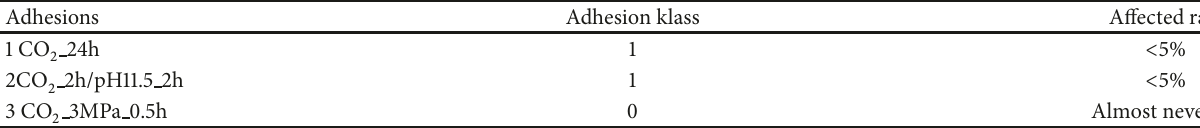
Table 2: Adhesion test results of LDH conversion coatings with various processes.